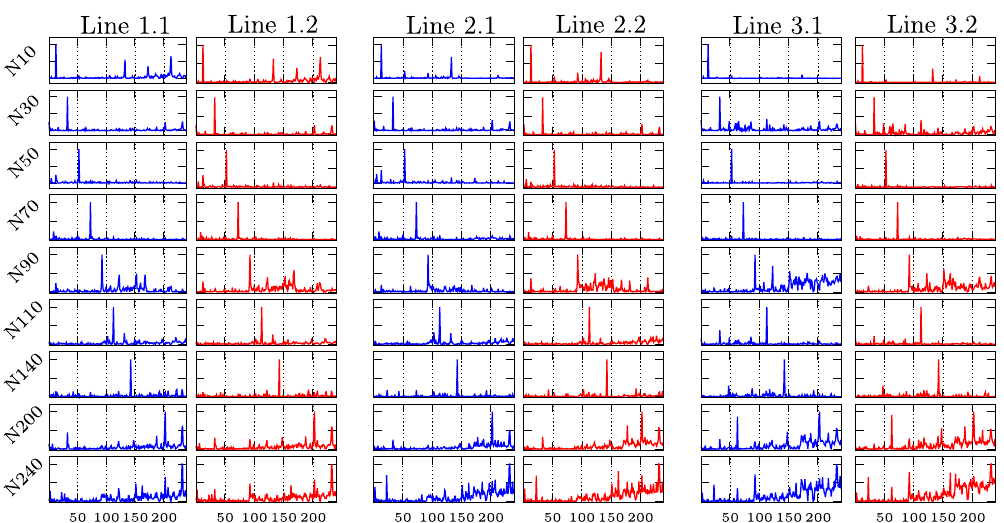
Figure 6. The metric m 2 computed for faults at different fault positions on the 6 lines detailed in Table 2 and Figure 4. Please note that m 2 is